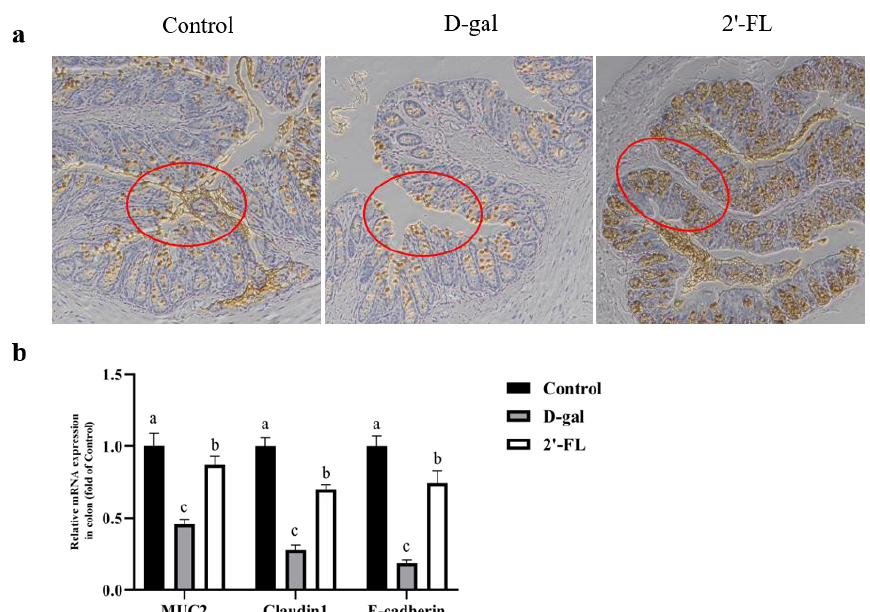
Figure 2. Effects of 2′− FL on the gut mucosal barrier. ( a ) Immunohistochemistry of the mucous layer (MUC2, zoom in 100 × ; circles indicate the expression of MUC2). ( b ) Expression of mucoprotein and tight junction proteins at the gene level. Letters a, b, and c indicated significant differences between groups ( p < 0.05).